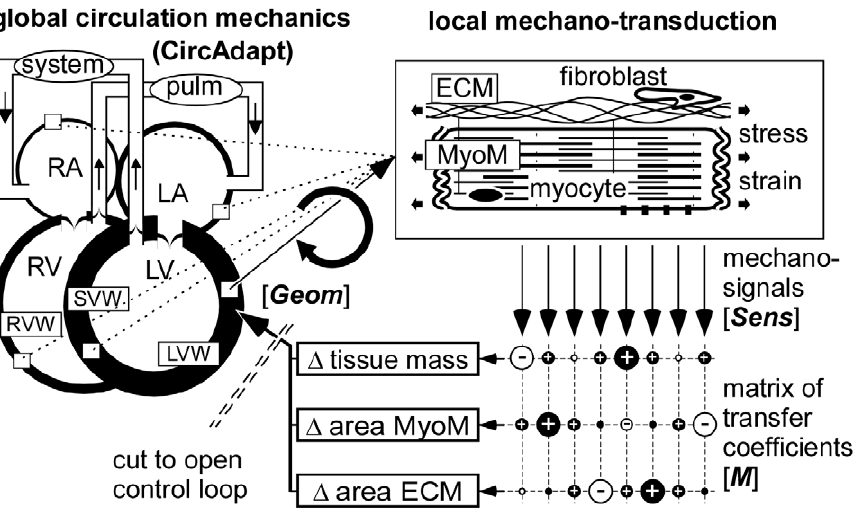
Figure 3. Modeling control of myocardial wall geometry. In the CircAdapt model of the whole circulation (left), geometry of the walls determines hemodynamic performance, which in turn determines mechanical load of the wall material (upper right). Local mechano-sensing invokes changes in tissue structure (lower mid) and geometry, by which the control loop for adaptation of wall geometry is closed. A matrix of transfer coefficients (lower right) is used to estimate changes in tissue structure, causing geometry to adapt. Symbols [ Sens , M , Geom ] are used in Eq. (2–9).